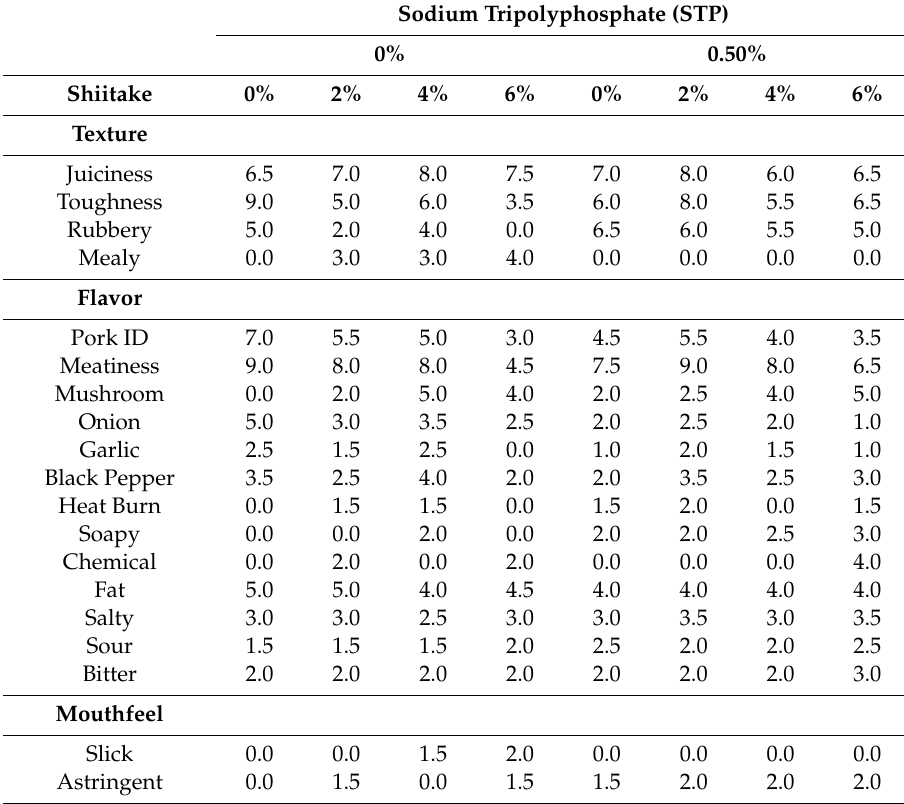
Table 3. Flavor and texture profile scores for pork patties with varied percentages of shiitake mushroom powder with and without